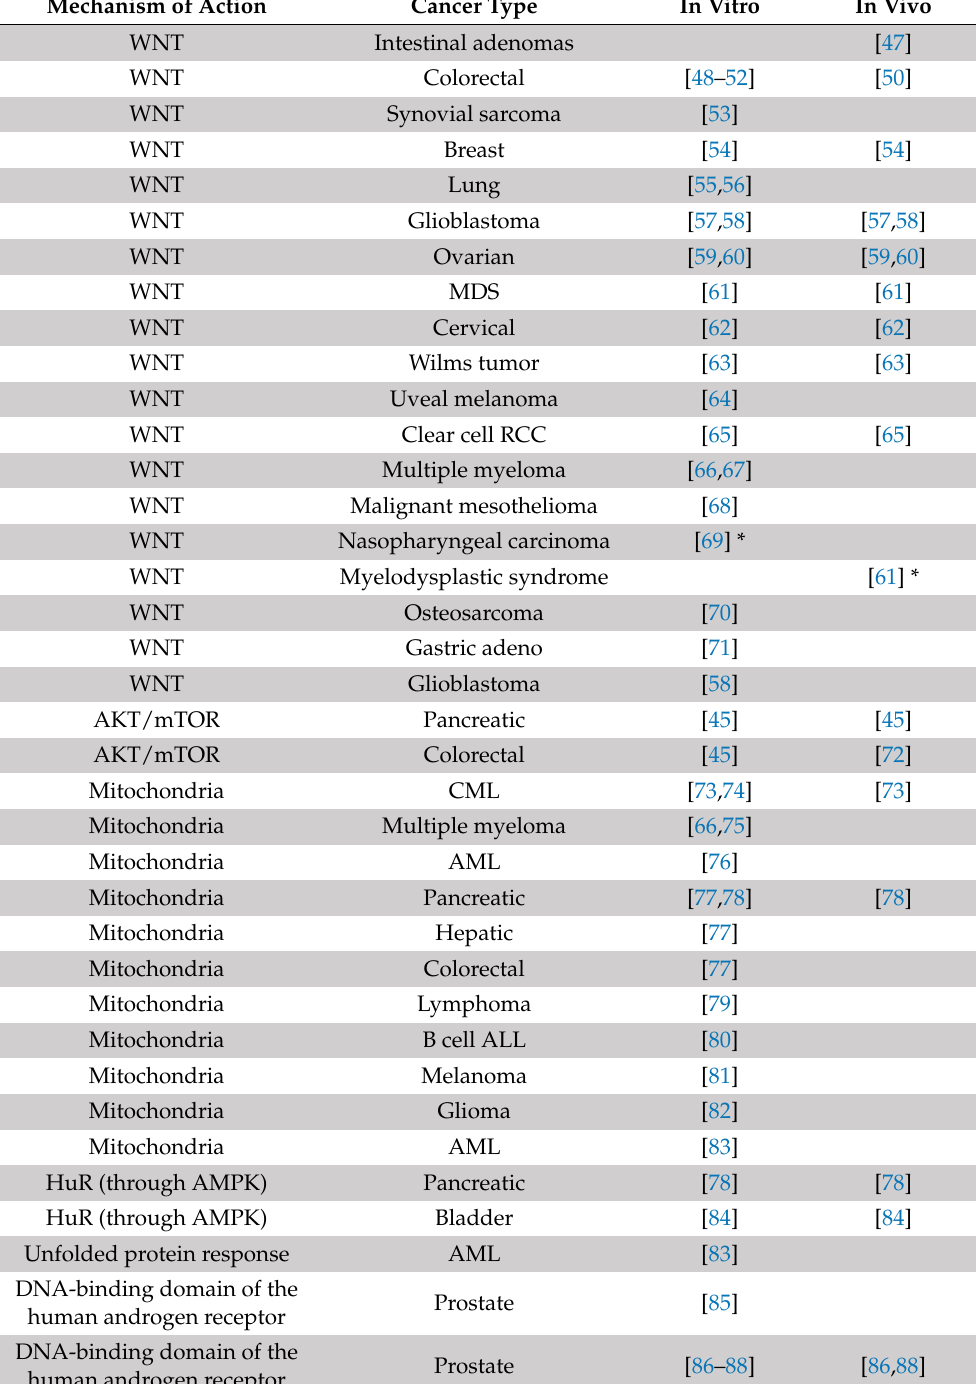
Table 1. Pyrvinium pamoate as an anti-cancer agent: Instances of PP as an anticancer agent were assessed by cancer type, whether it was used in vitro or in vivo, and what mechanism of action the authors claimed PP had in their cancer type/model. * is indicative of publications using pyrvinium tosylate as opposed to pyrvinium